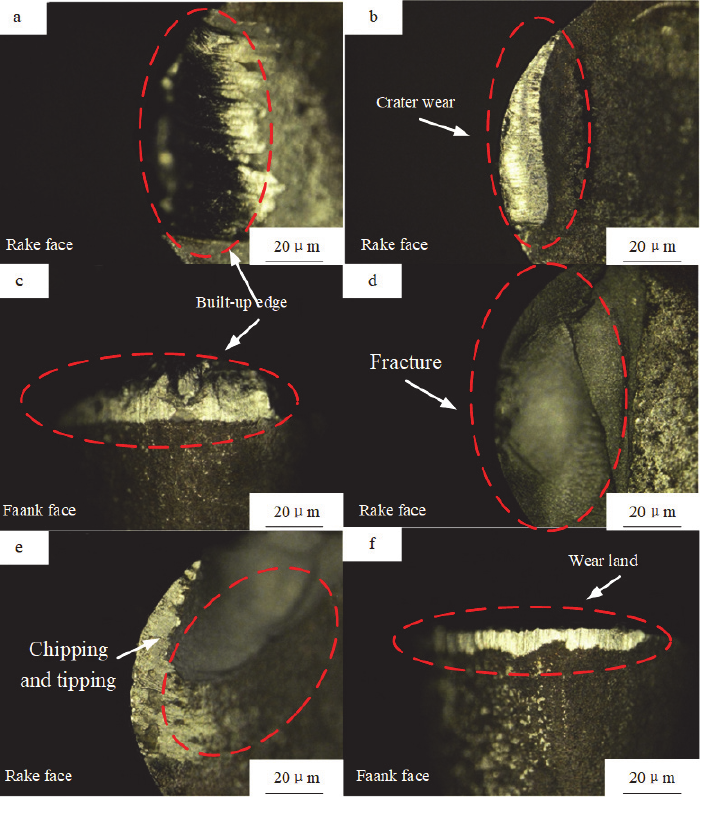
Figure 9. Tool wear morphology with different cutting parameters. (( a , c ): v c = 25 m/min, f = 0.1 mm/rev; ( b ): v c = 145 m/min, f = 0.05 mm/rev; ( d ): v c = 55 m/min, f = 0.3 mm/rev; ( e ): v c = 145 m/min, f = 0.1 mm/rev; ( f ): v c = 145 m/min, f = 0.02 mm/rev) [16].